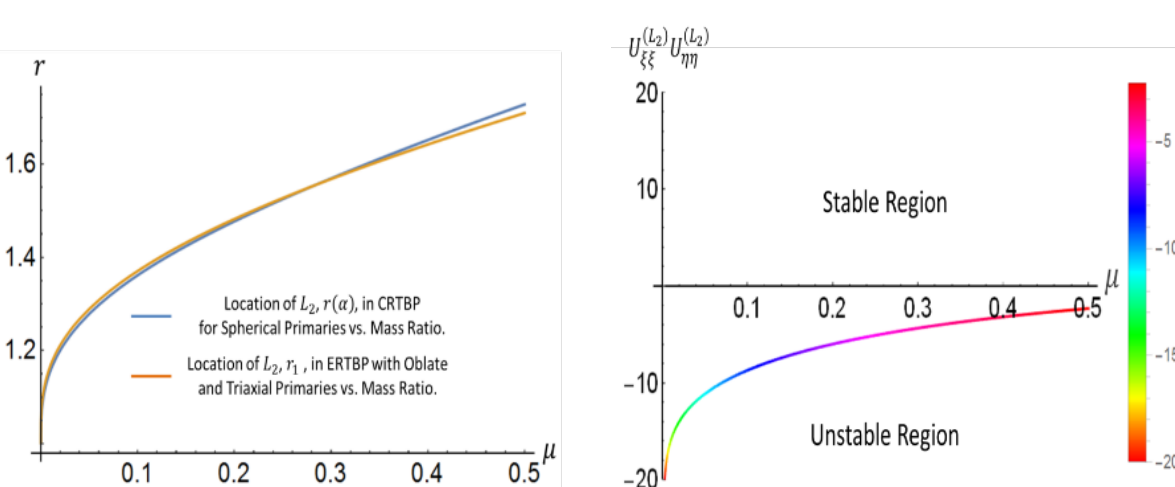
Figure 3. Stability region vs. µ for L 1 for ERTBP with oblate and triaxial primaries.